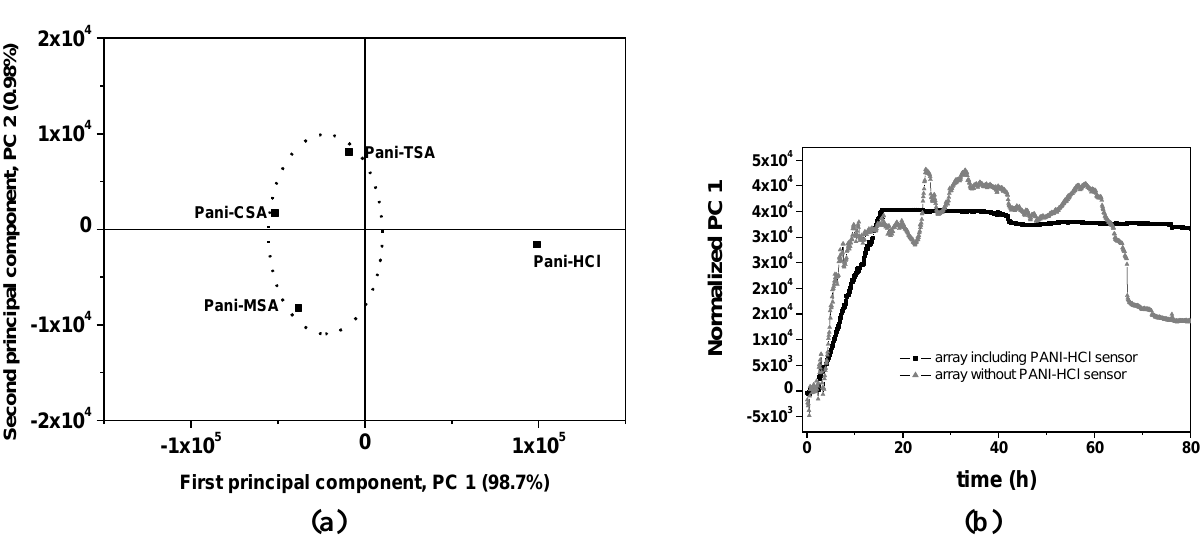
Figure 5. (a) PCA chart of first two principal components and (b) normalized PC1 against the